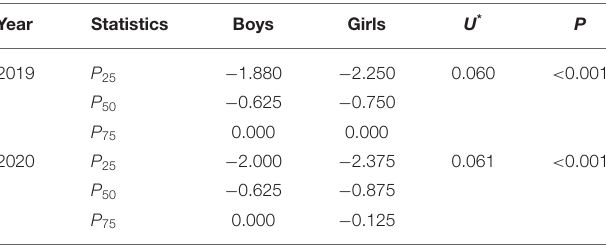
TABLE 3 | The quartiles of spherical equivalent refraction in the right eyes of primary and secondary school